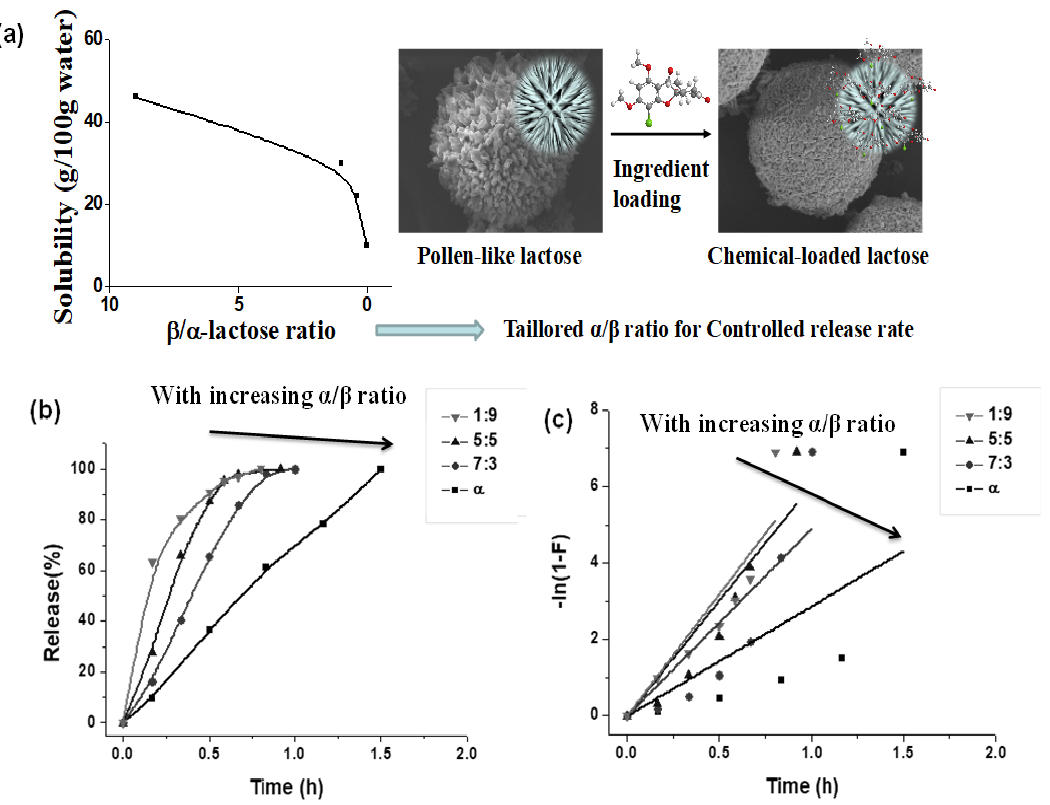
Figure 6. ( a ) Schematic diagram for the mechanism of controlled release by tailoring α / β ratio of lactose. ( b ) Release profiles of acetamidophenol from the lactose-carried tablets in simulated gastric fluid with tailored α / β ratio of lactose. ( c ) Linear fitting for the release profiles using the first-order release model.